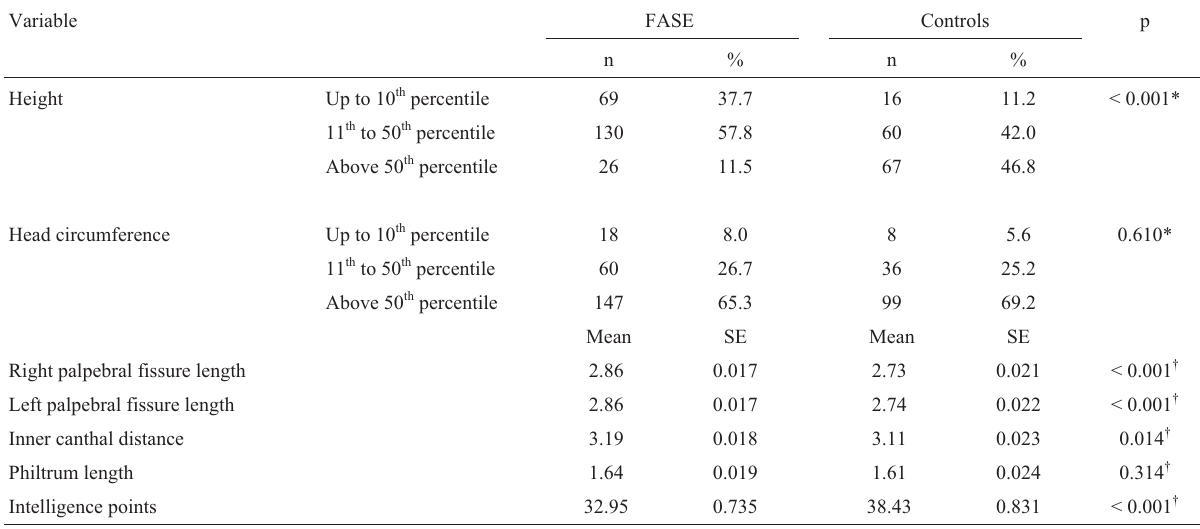
Table 3 - FAS signs in adolescents with criminal behavior (FASE) and in the school students (controls). Variable